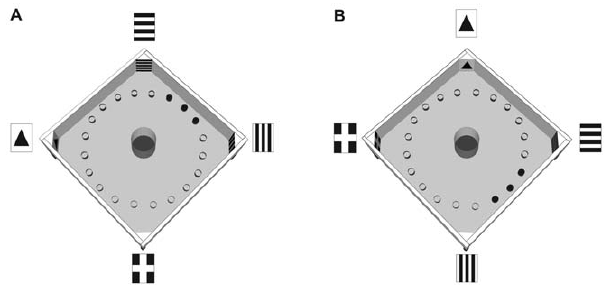
Figure 1. Experimental arena. In the arena (150 6 150 6 50 cm) 20 identical food cups were arranged in a circle and four distinct visual landmarks placed in the corners. The central, transparent starting cylinder could be retracted into the floor. Filled circles represent baited food cups. Quails were trained to find food between two specific landmarks (A). In the test, landmarks and positions of baited food cups were shifted 90 u clockwise